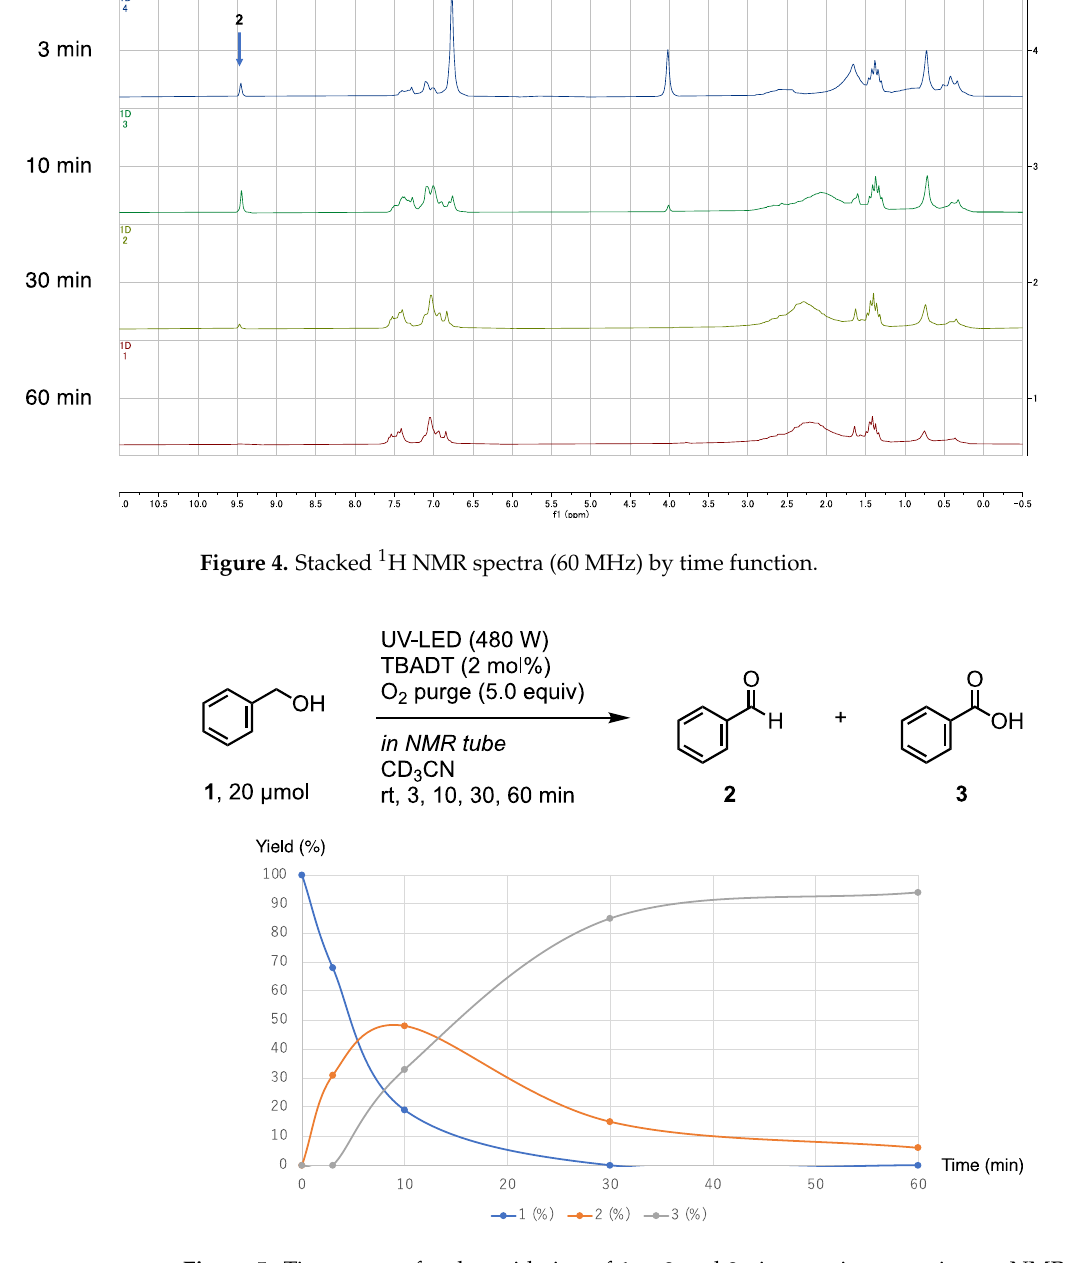
Figure 5. Time course for the oxidation of 1 to 2 and 3 via experiments using an NMR tube and irradiation by UV-LED at 480 W.